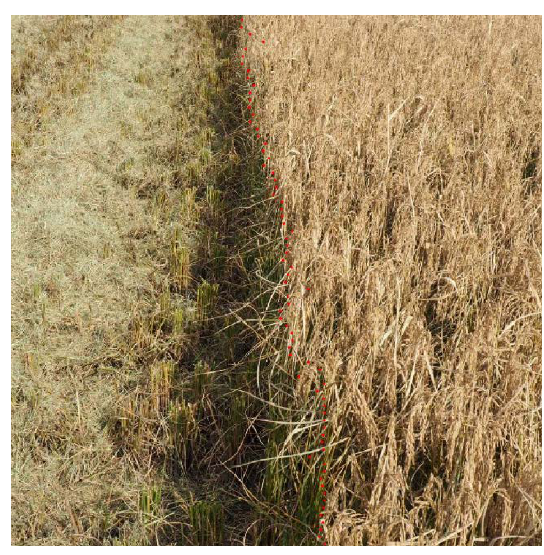
Figure 8. Dividing point extraction process.